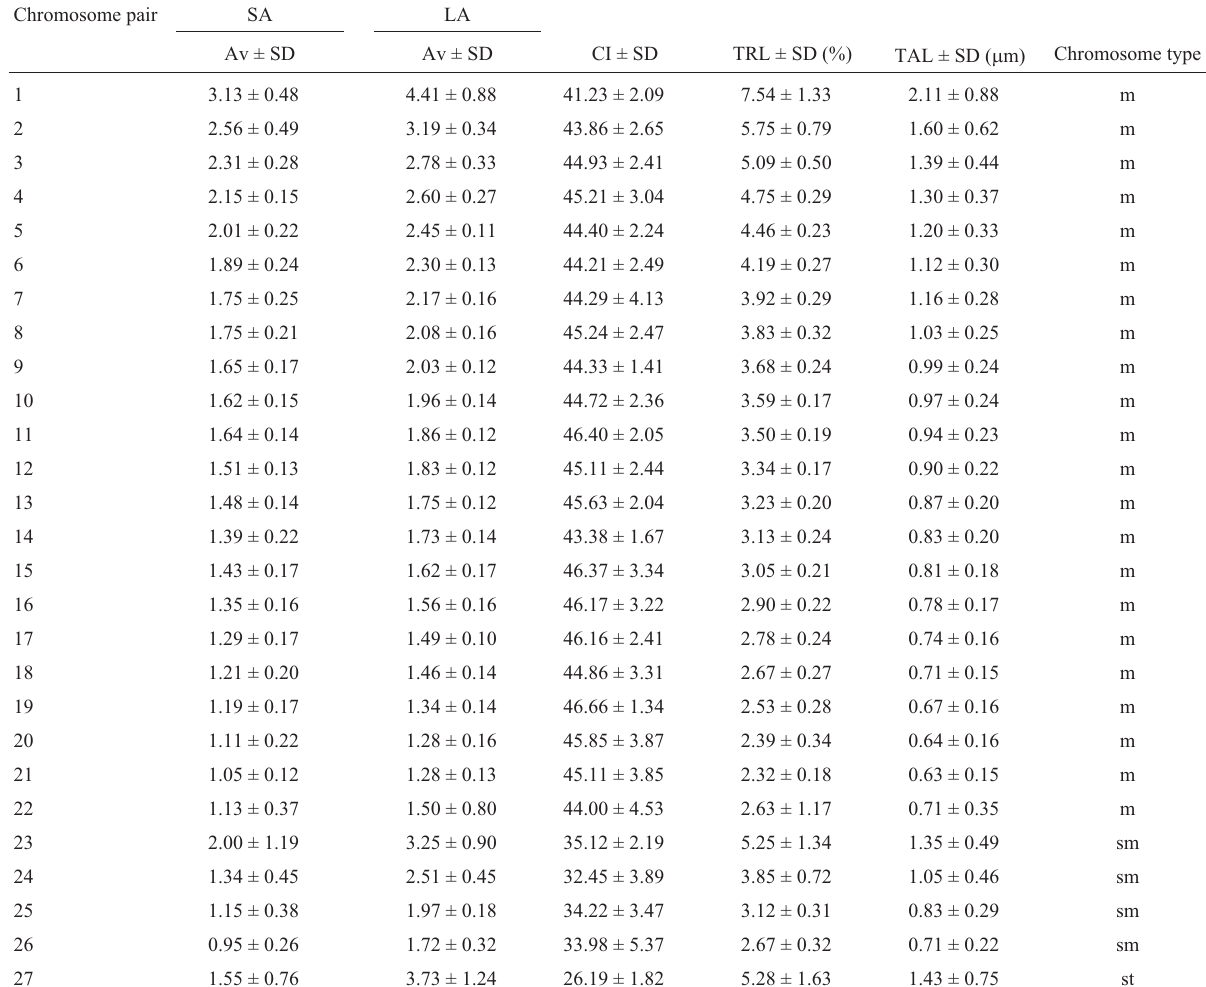
Table 1 - Values of karyotype parameters in T. areolatus (2n = 54) (n = 9 chromosome metaphase plates): average relative length in percentage of short arm (SA) and long arm (LA) of each chromosome pair are shown; total relative length (TRL) and total absolute length (TAL) of each chromosome pair are also shown. The chromosome types were classified according to the centromeric index (CI). SD = standard deviation. Chromosome